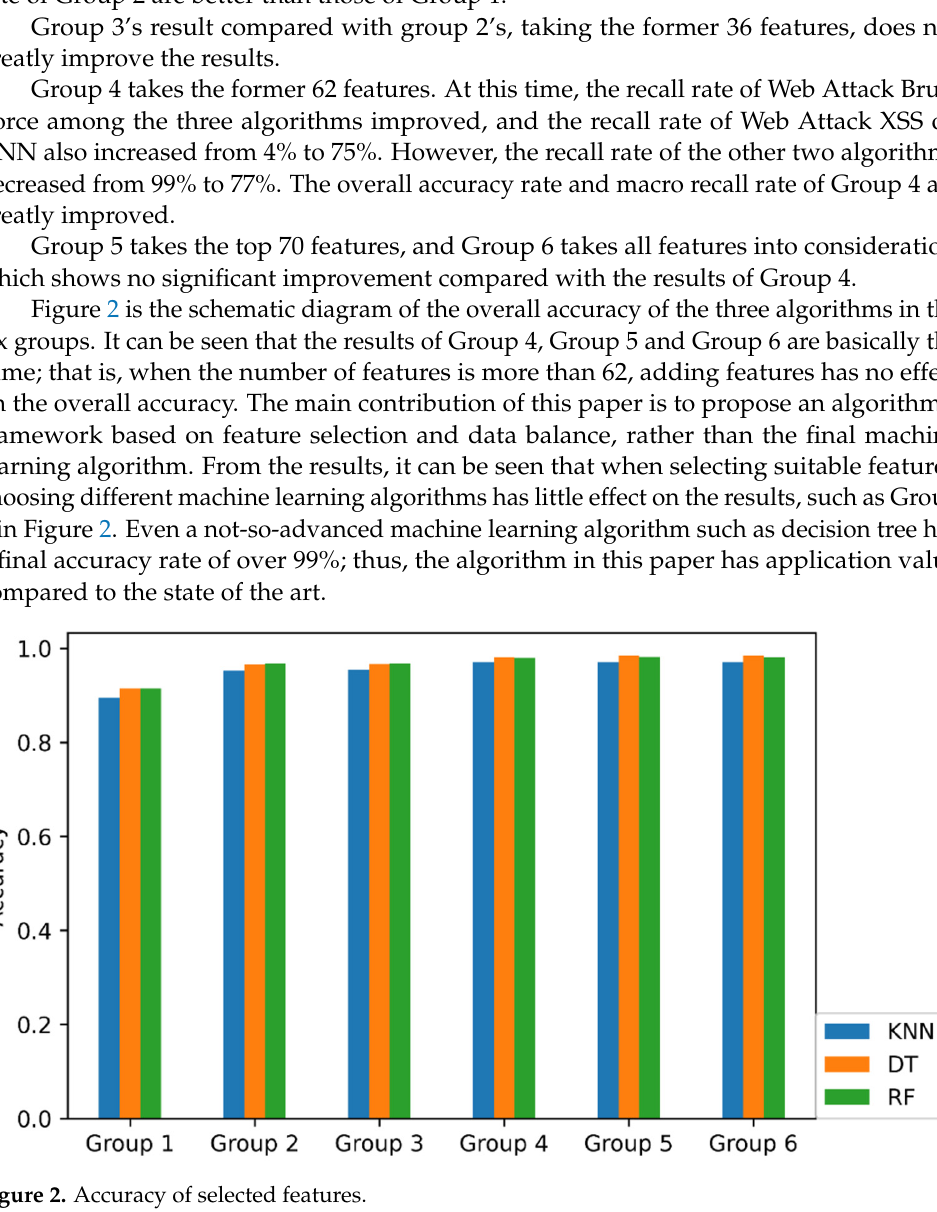
Figure 2. Accuracy of selected features.